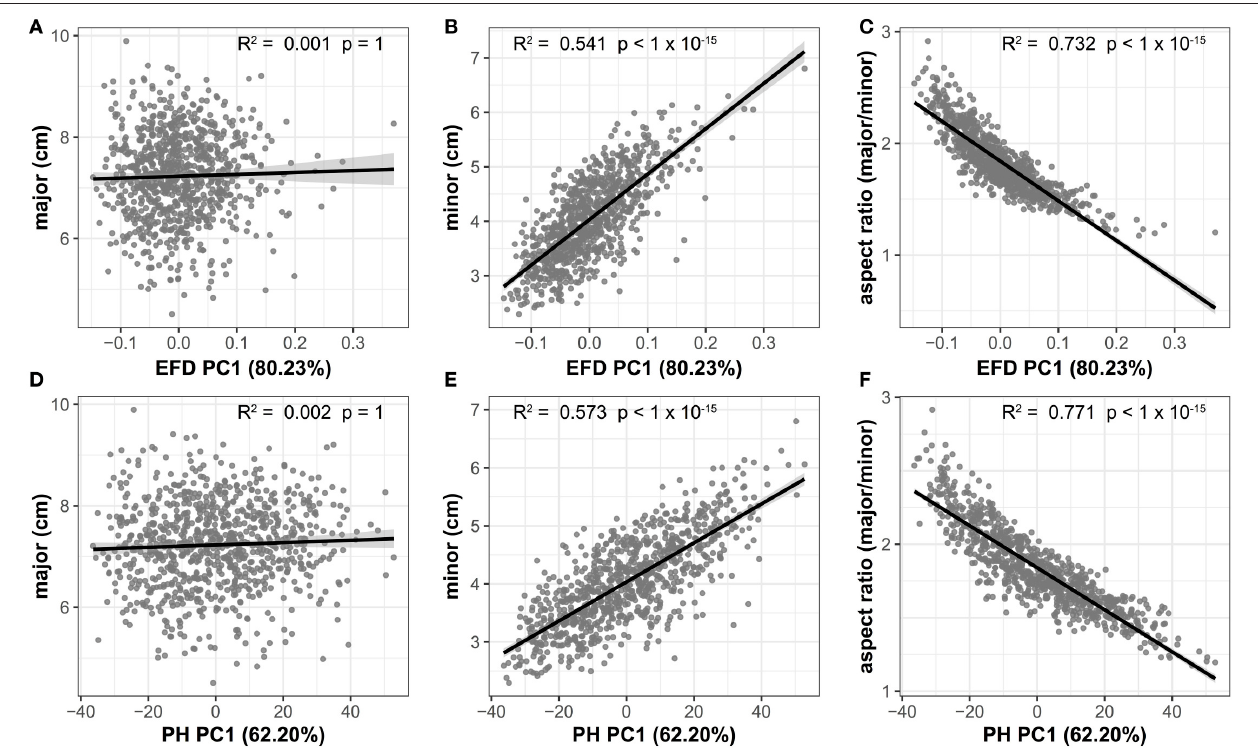
FIGURE 5 | Correlation between the primary axis of variation (PC1) captured using EFD and PH values and leaf shape measures. EFD PC1 is plotted against the major axis (length of leaf blade) (A) , minor axis (width of leaf blade) (B) and aspect ratio (ratio of length-to-width of blade) (C) . PH PC1 is plotted against the same measures in (D–F) . The percent variances explained by PC1, prior to REML-adjustment, is shown in parentheses. All p -values are Bonferonni-corrected based on the number of comparisons in Figure 4 . A regression line from a linear model with a shaded 95% confidence interval is also shown.